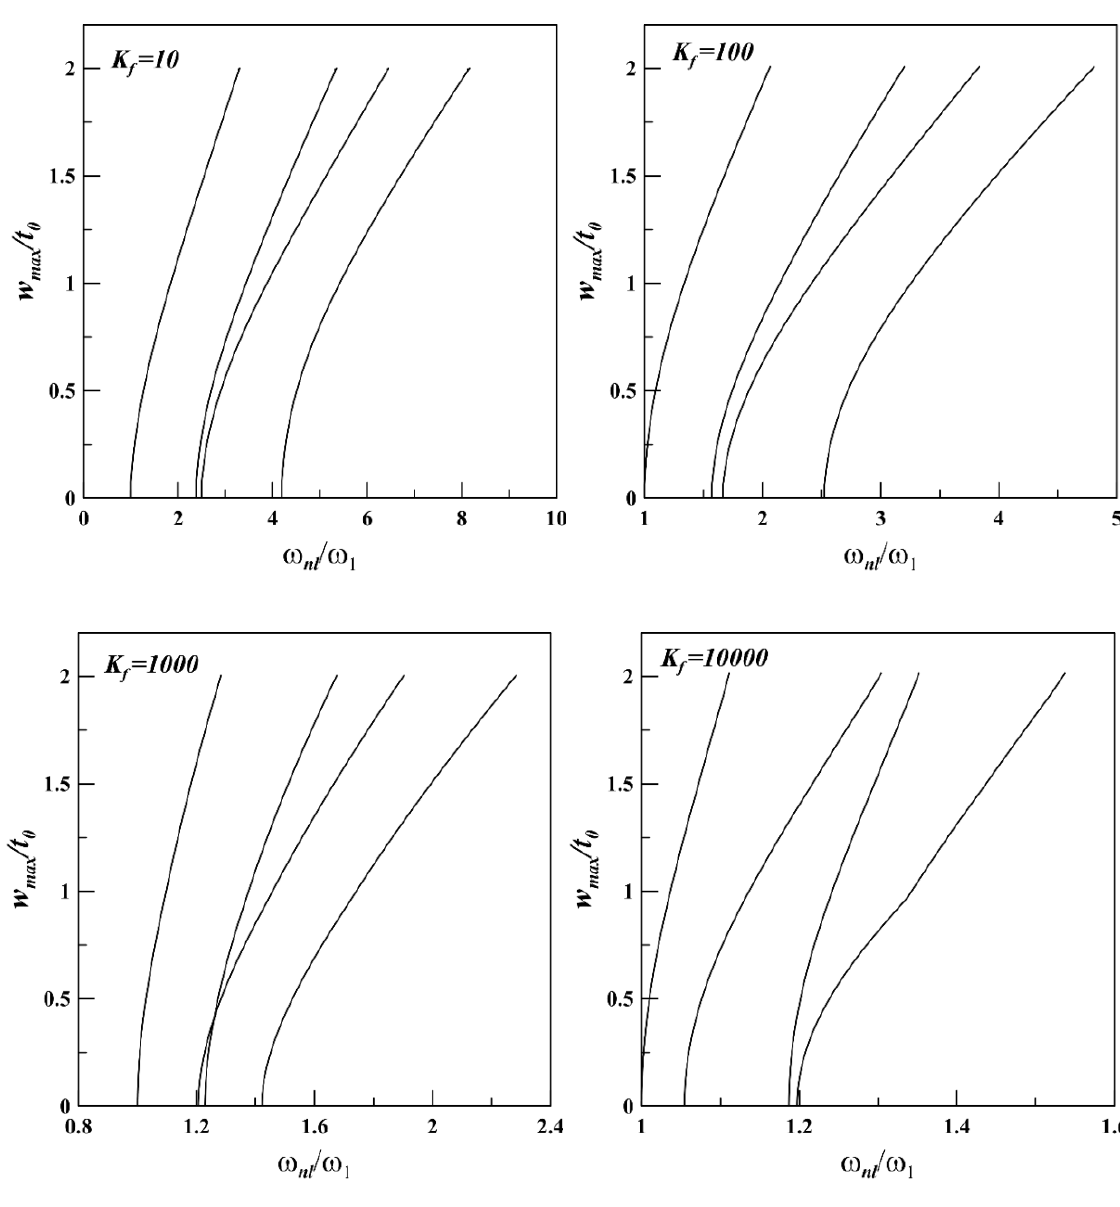
Figure 8: Backbone curves of SCSF plate for various foundation stiffness at α , β = 0.5